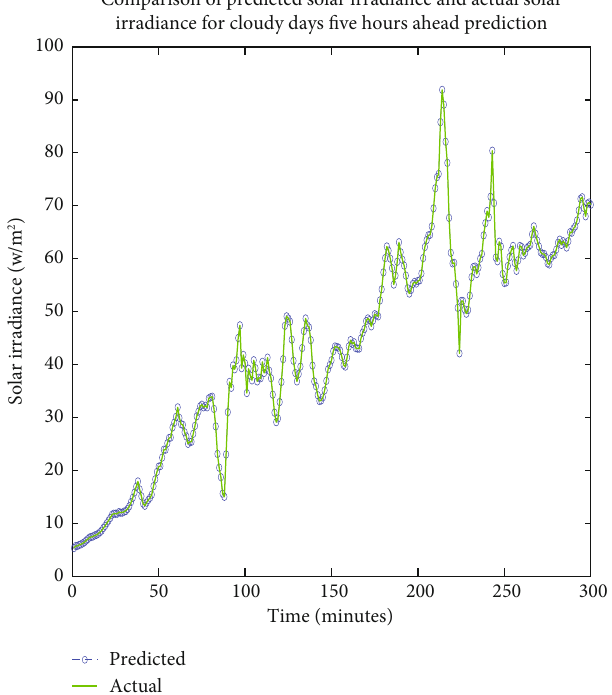
Figure 34: Comparison of predicted solar irradiance and actual solar irradiance for cloudy day fi ve-hour-ahead prediction.